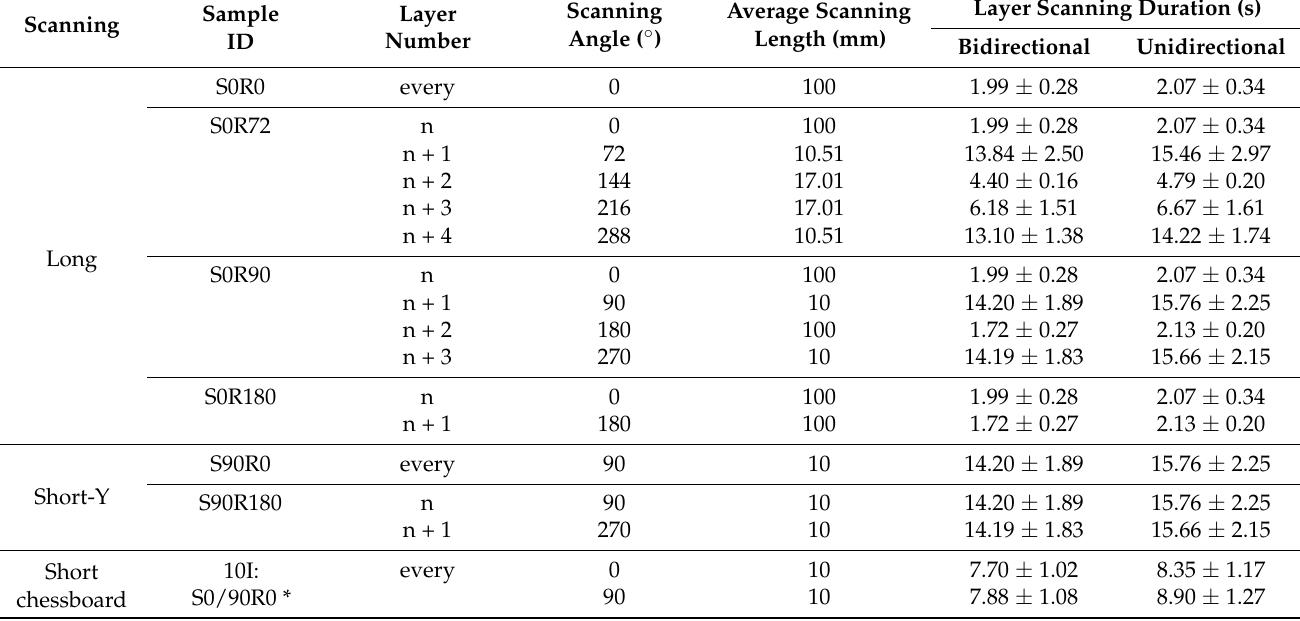
Figure 4. Schematic of the unidirectional chessboard printing. As shown, the chessboard printing was achieved by dividing the entire slice into several (10 for this work) islands, where each island was melted one after another. Table 2. The summary of different parts according to their different scanning angle, length and time.